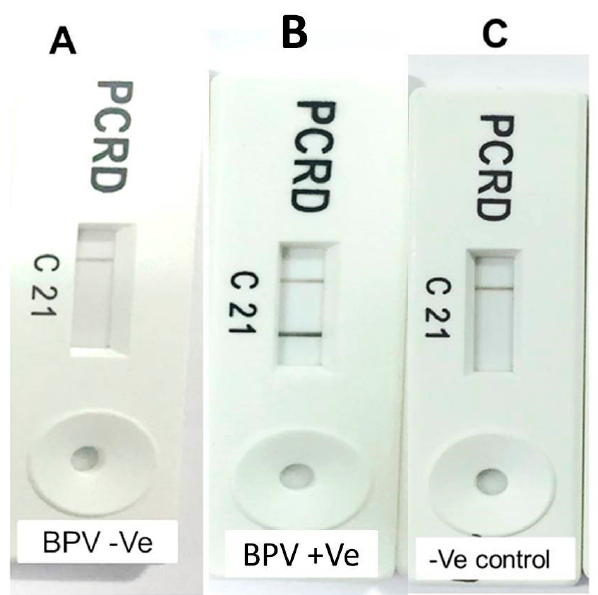
Figure 4. Results of recombinase polymerase amplification (RPA) amplicons identification after 30-min incubation at 38 °C using a PCRD cassette: ( A ) BPV assay revealed a negative reaction, ( B ) BPV assay revealed a positive reaction, and ( C ) negative result of the negative control.